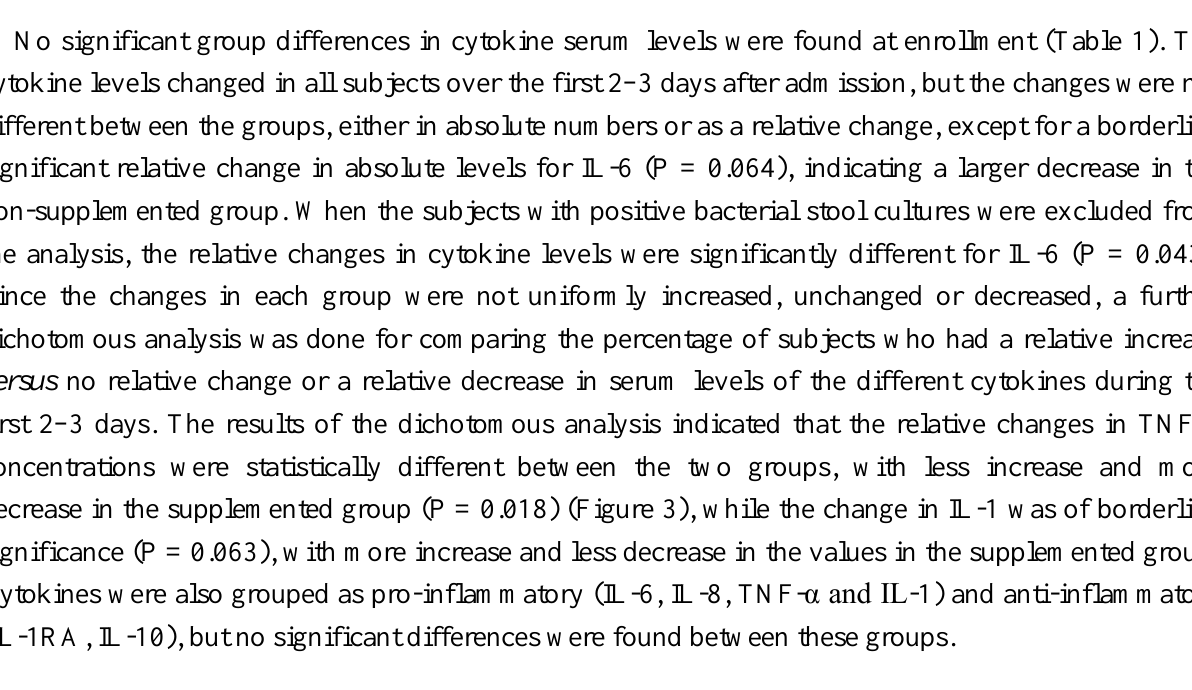
Figure 3. Changes in tumor necrosis factor (TNF-α) levels in each group over the first 48 hours of supplementation. Non-supplemented (N); supplemented